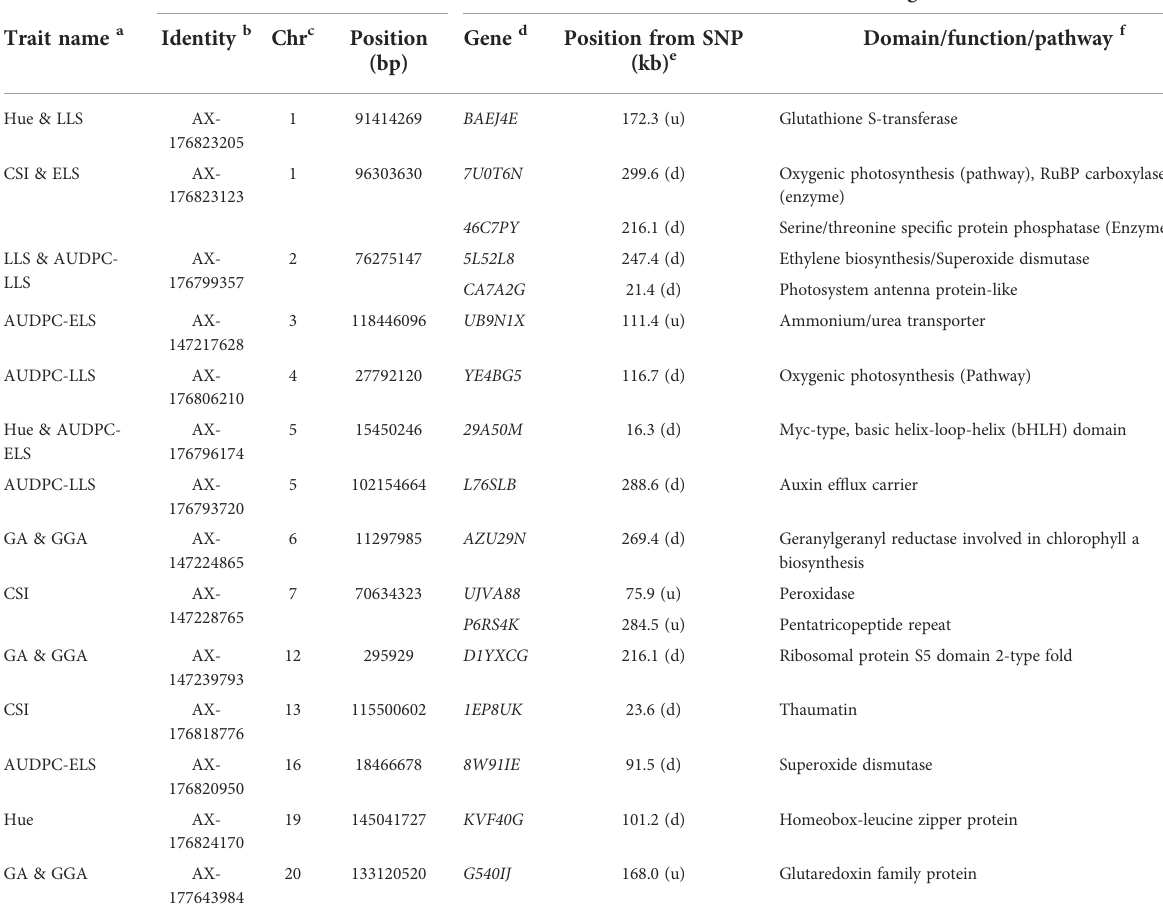
TABLE 5 Predicted candidate genes around fourteen stable/major SNPs for the studied traits. SNP